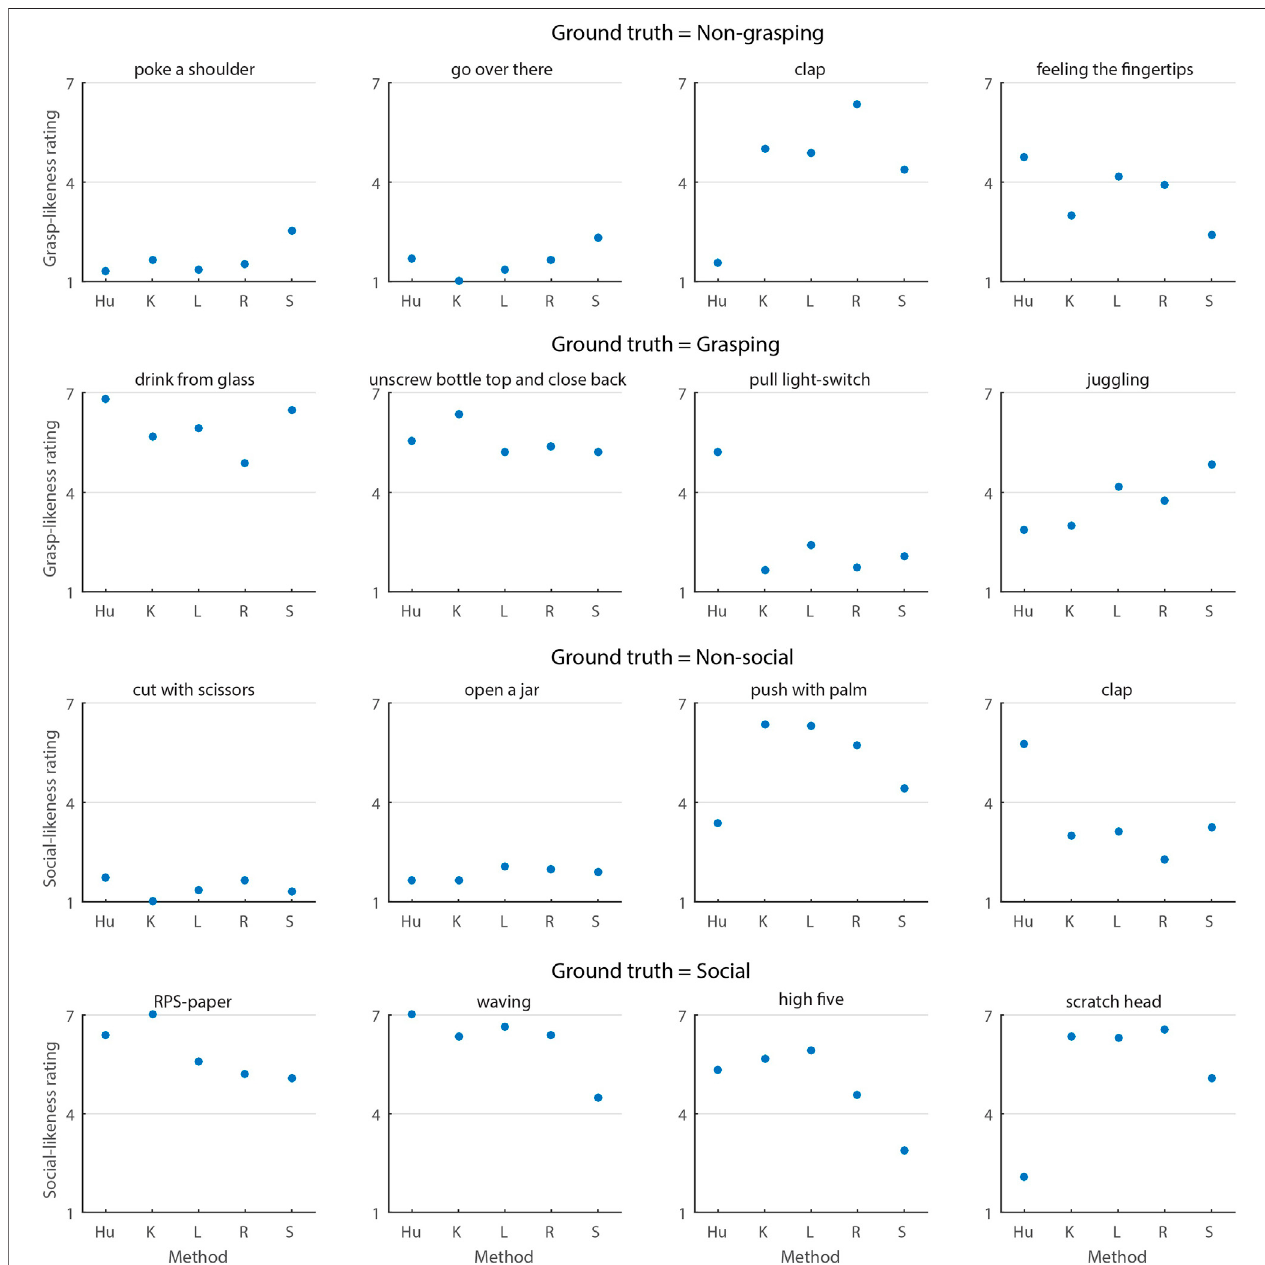
FIGURE 6 | The dotted line in each subplot separates non-grasping (lower part) from grasping (upper part) , or non-social (lower part) from social (upper part) . The valuesonthe y -axisareratingsfromthe7-pointLikertscale.Thevaluesonthe x -axisaredifferentmethods:Hu (cid:1) humanratings;K (cid:1) kNN;L (cid:1) LSH-F;R (cid:1) randomforest;S (cid:1) SVM.